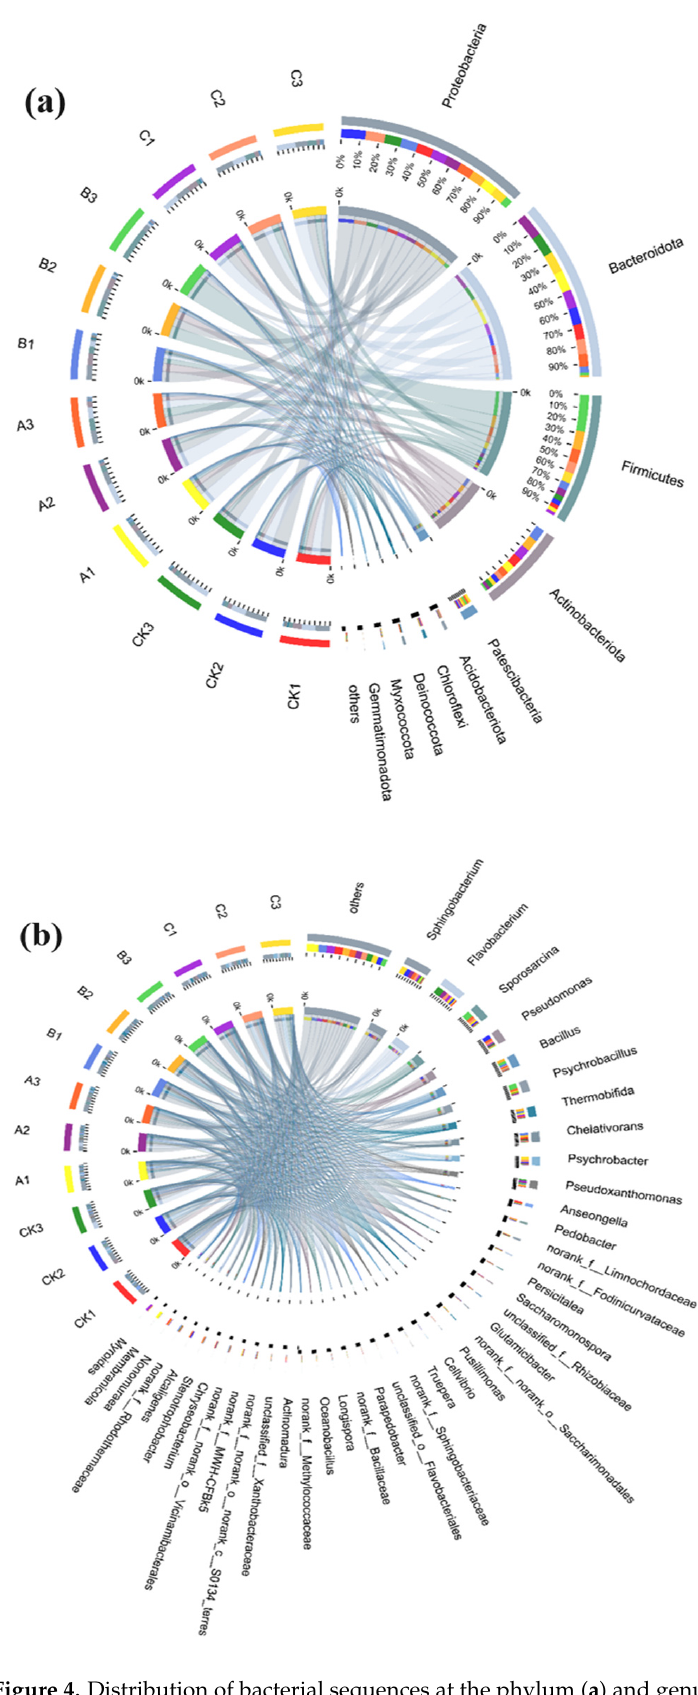
Figure 5. Distribution of bacterial sequences at the phylum ( a ) and genus ( b ) levels. Figure 4. Distribution of bacterial sequences at the phylum ( a ) and genus ( b )